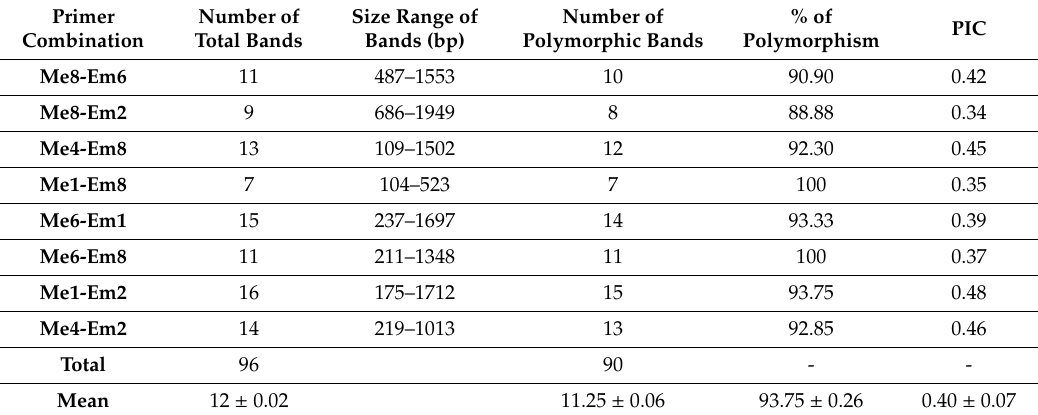
Table 2. List of SRAP primer pairs and the number of scored bands used in Streptocarpus.